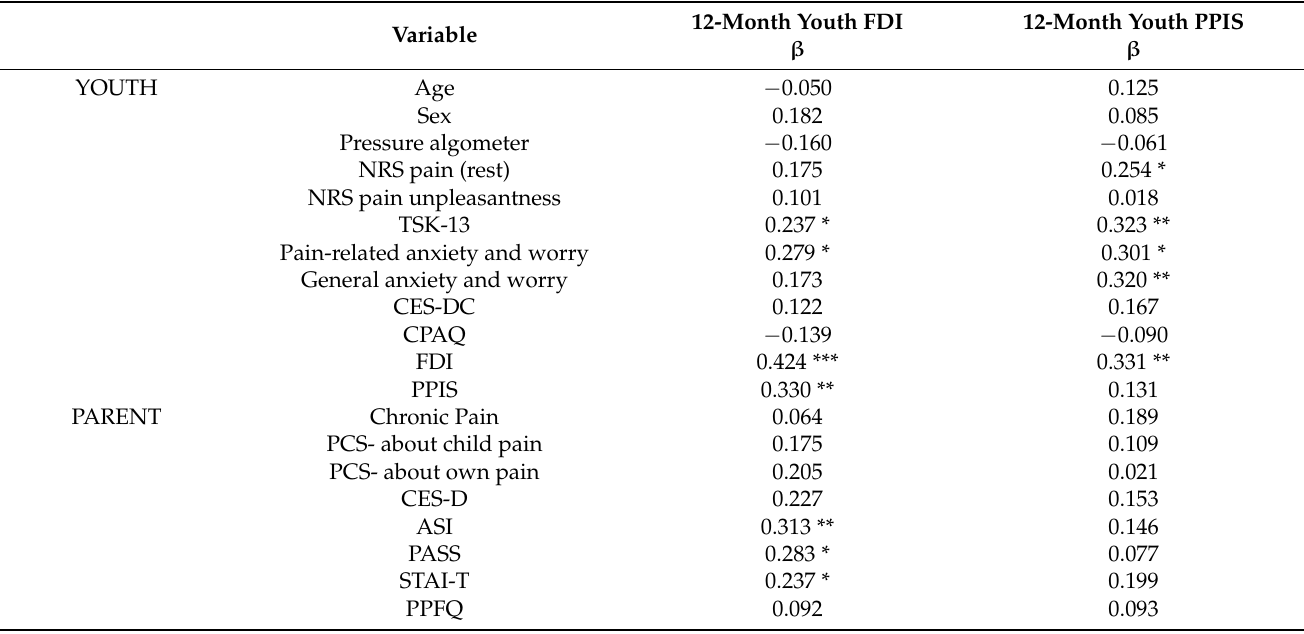
Table 1. Standardized regression coefficients ( β ) from univariate regression analyses predicting 12-month functional disability (FDI) and pain-related interference (PPIS) from pre-surgical parent and youth risk